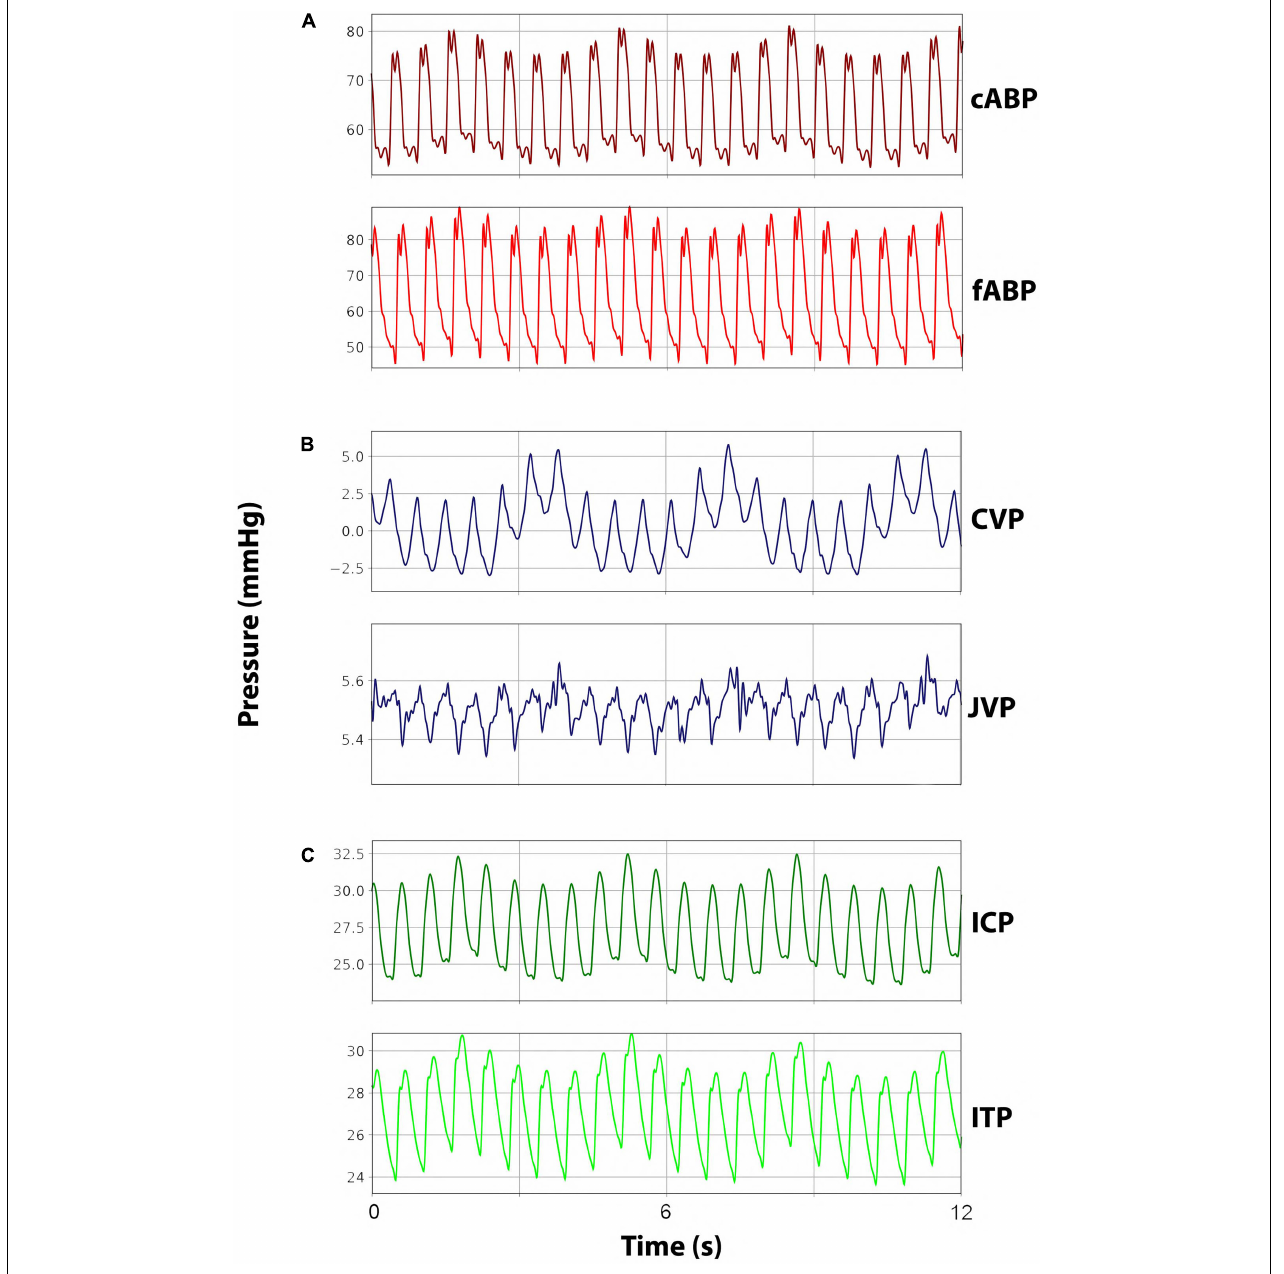
FIGURE 2 | Representative pressure waveforms. (A) Arterial blood pressure curves for carotid arterial blood pressure (cABP) and femoral arterial blood pressure (fABP). (B) Venous blood pressure curves for jugular venous pressure (JVP) and central venous pressure (CVP). (C) Cerebrospinal fluid pressure curves for intracranial pressure (ICP) and intrathecal pressure